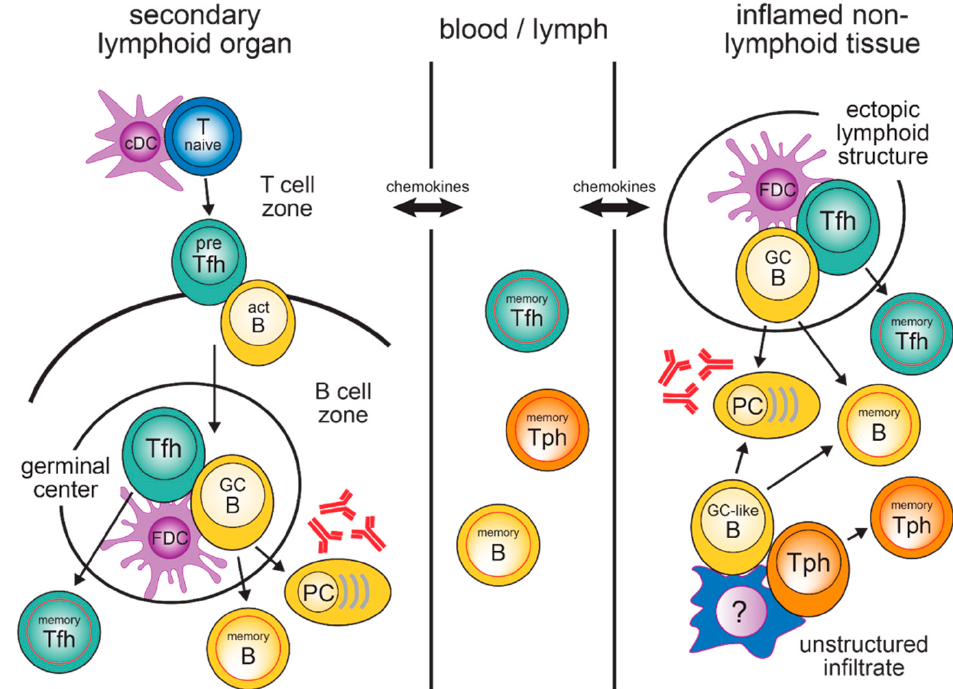
Figure 2. T cell/B cell cooperation in secondary lymphoid organs and inflamed non-lymphoid tissues. Abbreviations: act B, activated B cell; cDC, conventional dendritic cell; FDC, follicular dendritic cell; GC B, germinal centre B cell; PC, plasma cell; pre-Tfh, precursor Tfh cell; Tfh, follicular helper T cell; Tph, peripheral helper T cell.